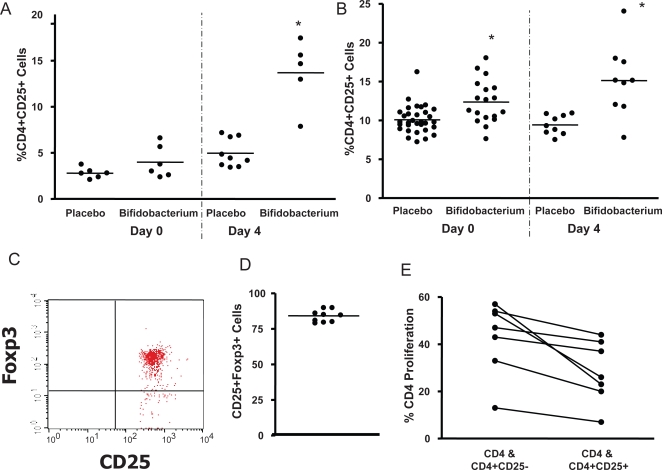

Bifidobacterium infantis consumption increases Treg numbers and activity in S. typhimurium infected mice.(A) There is a significant increase in the percentage of CD4+ cells co-expressing CD25 in the Peyer's patch of animals fed B. infantis, particularly following Salmonella infection; (B) There are also significantly more CD4+CD25+ cells in the spleen of animals fed B. infantis; (C) A representative flow cytometry dot-plot illustrates that the majority of the CD25+ cells within the spleen also stain positive for Foxp3 which is graphed for B. infantis-fed animals in (D); (E) CD4+CD25+ T cells suppressed proliferation of naïve CFSE labelled CD4+ cells while depletion of the CD25+ subset cells removed the suppressive effect. *p<0.05 versus placebo.